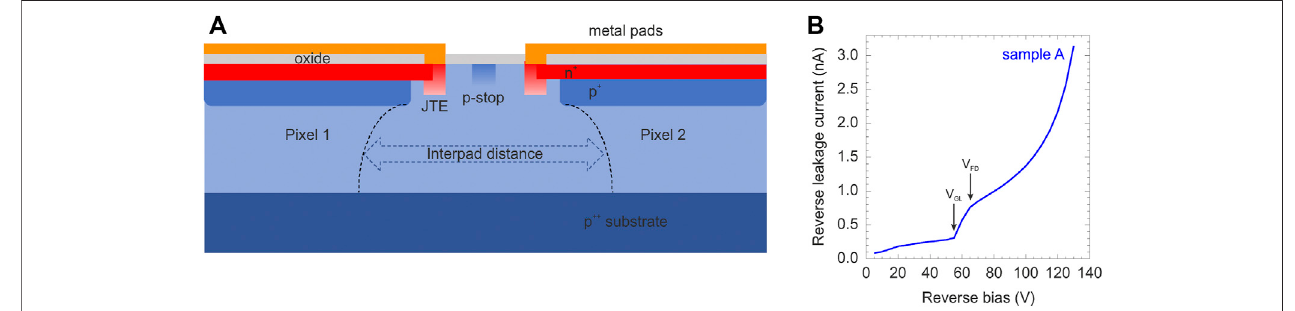
FIGURE 1 | (A) Sketch of the LGAD detector with indicated edge of pixels. (B) I/V curve for sample A with V GL and V FD positions.